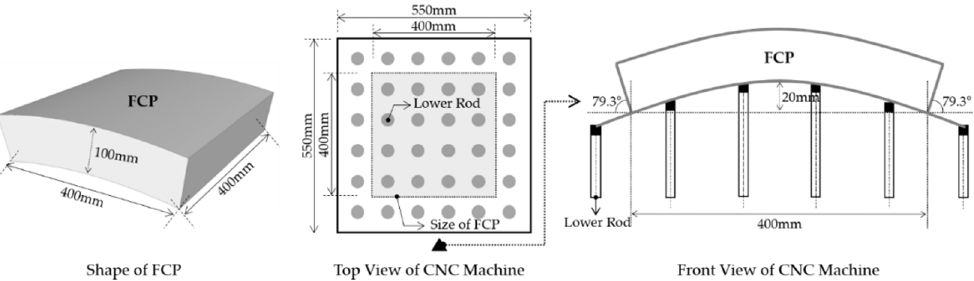
Figure 6. Variable side mold test settings.